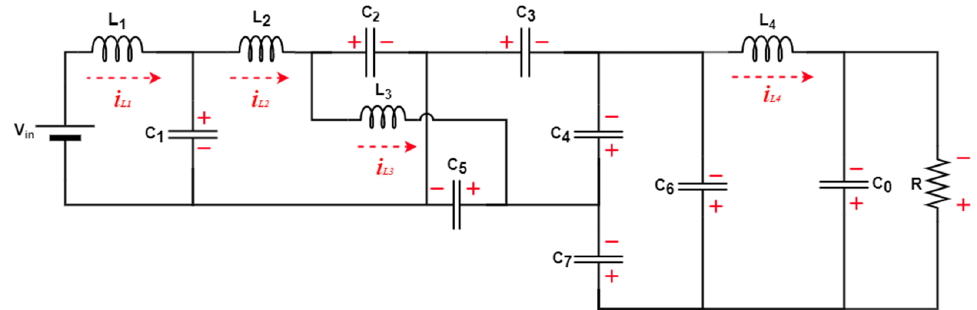
Figure 3. Modified high-gain CUK-based converter during OFF mode.